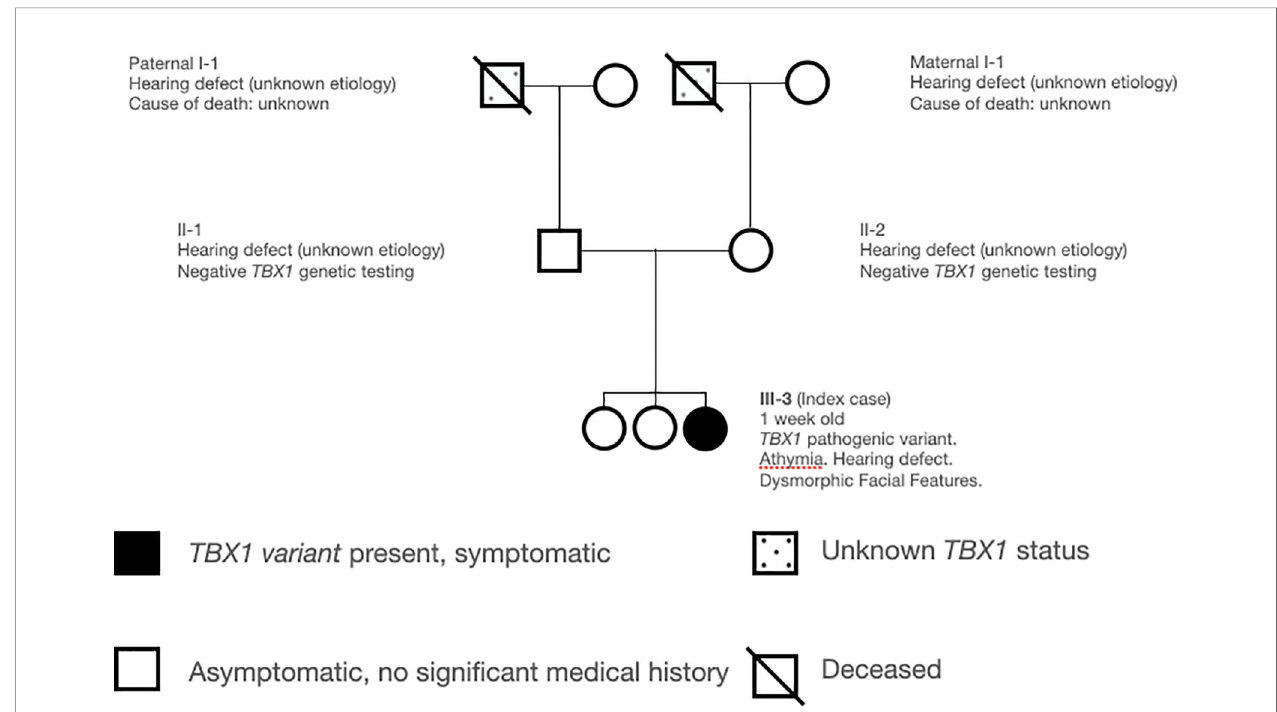
FIGURE 1 | Family